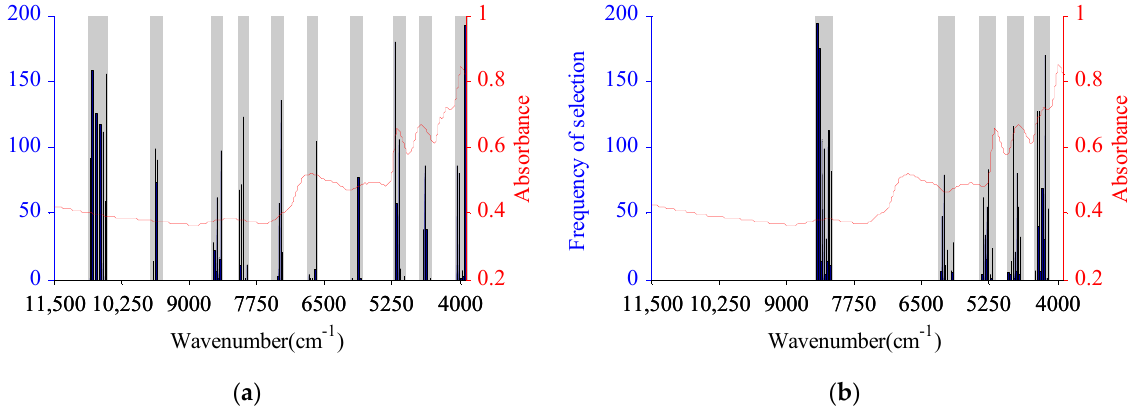
Figure 4. The characteristic wavelength variables selected by BIPLS-CARS optimized for cellulose ( a ) and hemicellulose ( b ).